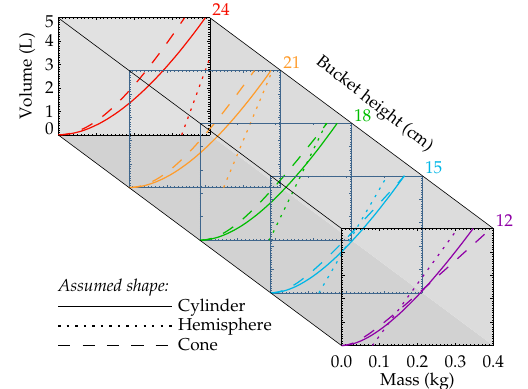
Figure 3. An ensemble of forward models for the volume of a bucket ( x axis) as a function of its mass ( y axis). A third param- eter, the bucket’s height, is not measured and so must be assumed. Its impact is shown over five slices of the z axis. Solid, dotted, and dashed lines denote cylindrical, hemispherical, and conical buckets respectively. The material is assumed to have thickness 1mm and density 2.7gcm − 3